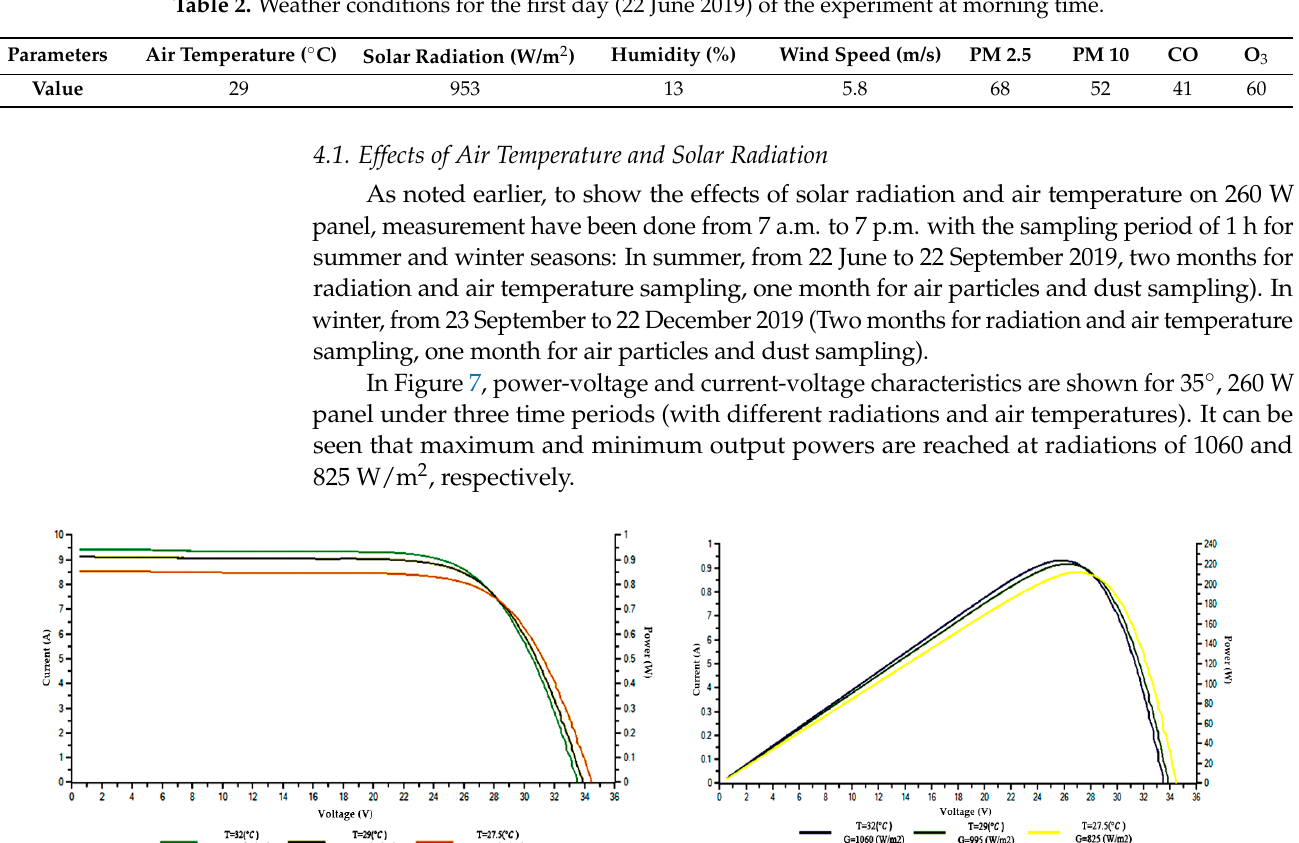
Figure 6. The voltage-current and generated power diagrams expected from the panel in standard and the first day of the experiment. Table 2. Weather conditions for the first day (22 June 2019) of the experiment at morning time.